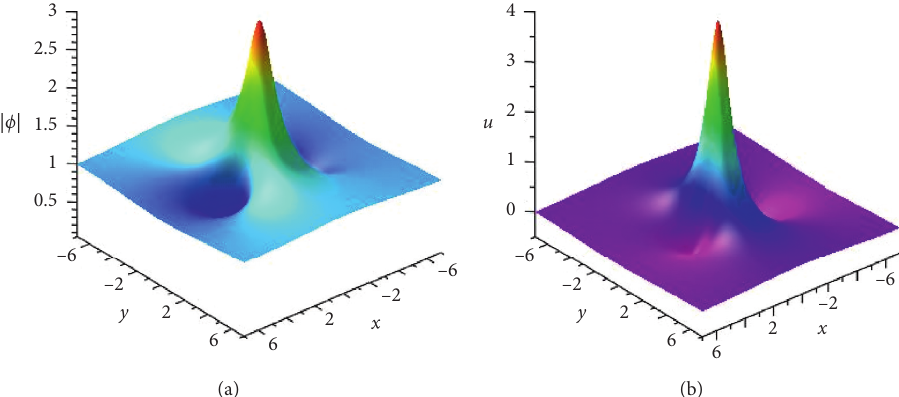
Figure 4: The one-lump solutions | ϕ | and | u | of the nonlocal Mel ′ nikov equation given by equation (34) with parameters κ � 1 , λ � 1 , and t �